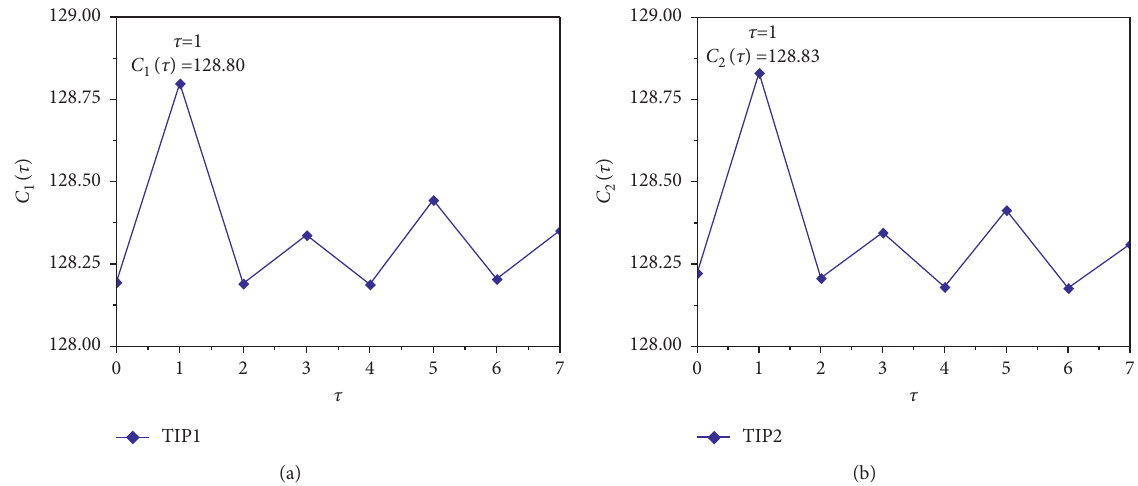
Figure 9: Correlation function calculation under resonant experimental condition of 2700r/min. (a) TIP1 sensor. (b) TIP2